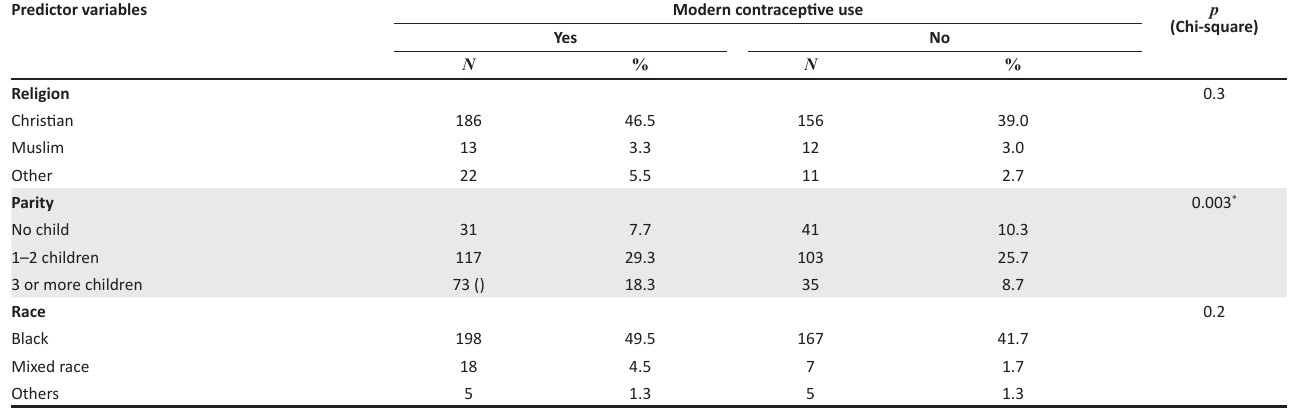
TABLE 2 (Continues...): Distribution of contraceptive use as per the four components of operational framework. Predictor variables